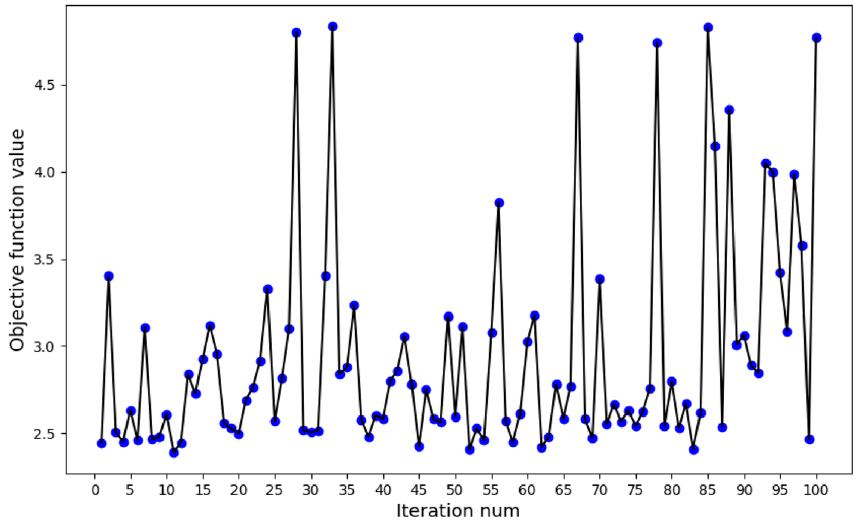
Figure 4. Iterative process of Bayesian optimization.